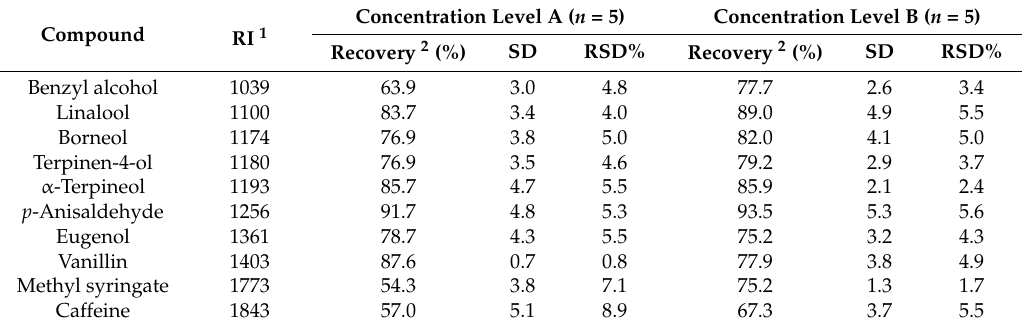
Table 1. The percentage of recovery and percent relative standard deviation (RSD%) of the volatile compounds extracted from a sugar model solution (artificial honey) using the dehydrating homogeneous liquid–liquid extraction (DHLLE)